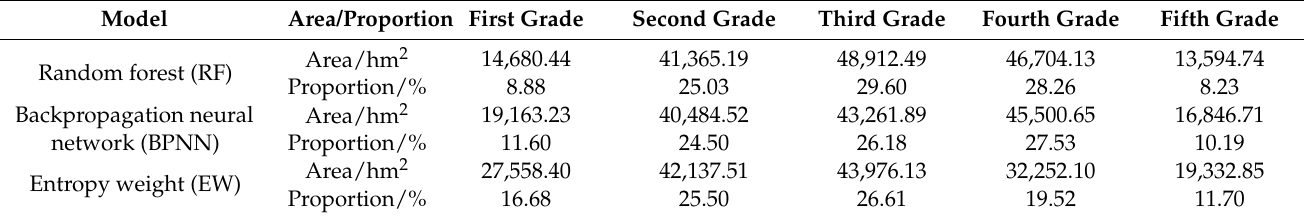
Table 5. Acreage and proportion of grades for the three methods of evaluating grades of farmland quality.